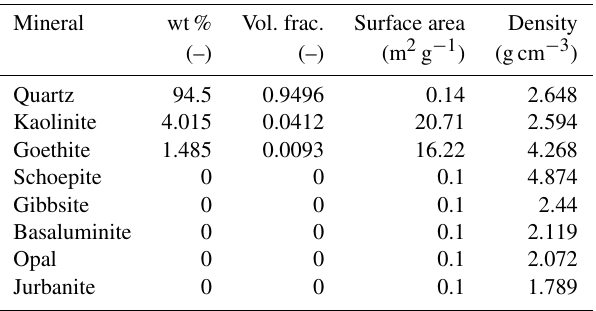
Table 3. Initial mineral volumetric fraction distribution in the sim- ulation (Bea et al., 2013).